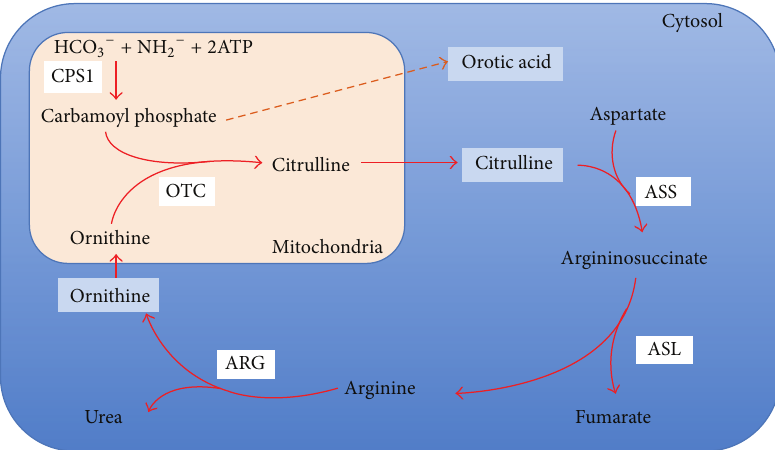
Figure 3: Schematic diagram of urea cycle and associated enzymes, CPS1: carbamoyl phosphate synthase 1; OTC: ornithine transcarbamylase; ARG: arginase; ASS: argininosuccinate synthetase; ASL: argininosuccinate lyase; ATP: adenosine triphosphate. Table 3: Differential diagnosis of nonhepatic hyperammonemia based on [3–8].